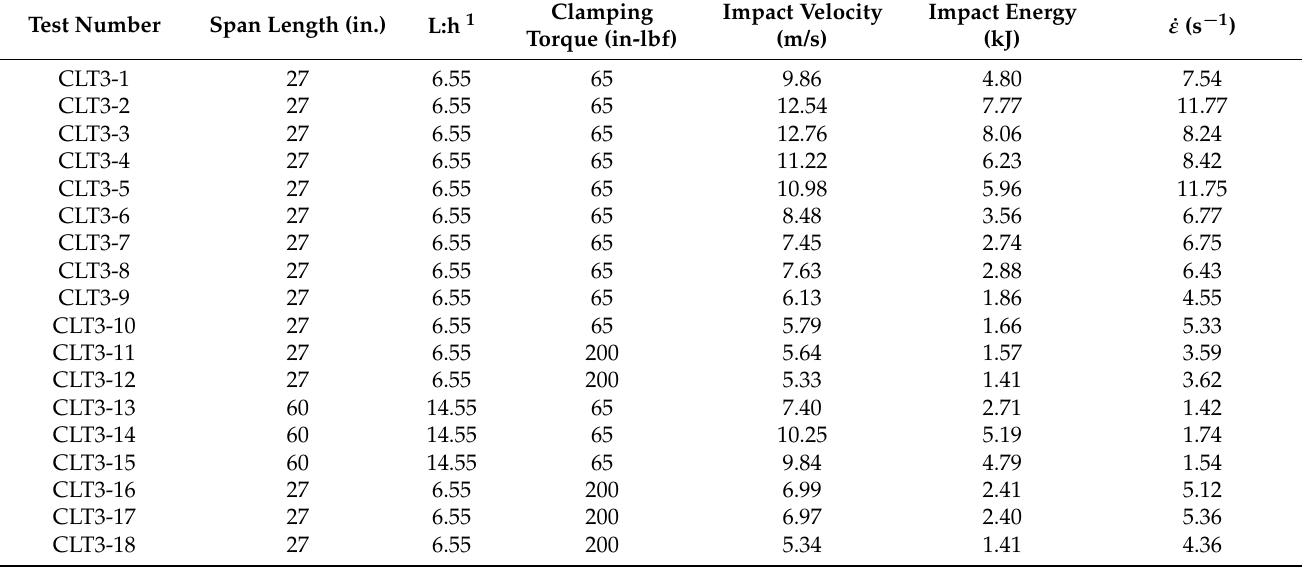
Table 1. Impulsive Center-Point Test Matrix for Three-Laminae CLT.